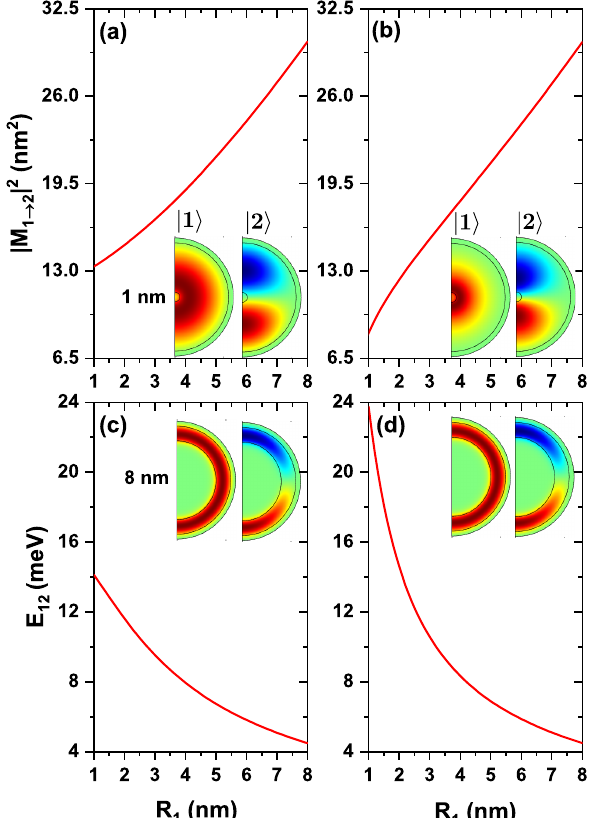
Figure 5. The variation of the | M 12 | 2 ( a , b ), and the transition energy ( c , d ), as functions of the internal radius R 1 , for transitions from the ground state ( | 1 (cid:105) ) to the first excited state ( | 2 (cid:105) ) with m = 0, for an electron confined in a ZnS/CdS/ZnS spherical QD. ( a , c ), present the results without, and ( b , d ) with the effects of a donor impurity located at the center of the dot system. Calculations are with R 2 = 11nm and R 3 = 12nm, without effects of external electric and magnetic fields. Variation of | M 12 | 2 and transition energy, E 12 , as functions of the internal radius for a confined electron in a ZnS/CdS/ZnS spherical QD with and without the effects of on- center donor impurity is shown in Figure 5. According to Figure 5a, by increasing the QD internal radius, the size of the shell -where the electron is confined- decreases, causing a linear increase of | M 12 | 2 . This behavior is shown in the inset, from which one may conclude that the spatial overlap between wave functions increases when moving from 1 nm to 8 nm in the internal radius. In Figure 5b, with the inclusion of donor impurity influence, a similar behavior is observed for | M 12 | 2 . From the inset in Figure 5b, it is seen that the ground state wave function is attracted to the impurity while the first excited wave function remains almost unchanged. Hence, the overlap between both states decreases concerning the case without impurity. For example, | M 12 | 2 has a value of 13.330 nm 2 for R 1 = 1 nm without impurity. With impurity effects, the value falls to 8.380 nm 2 , with a difference of 4.950 nm 2 , which becomes smaller as the radius increases, weakening the Coulombic interaction. Figure 5c,d show the corresponding variation of the transition energy from the ground state to the first excited state, with and without impurity, from which it is seen that as the R 1 increases, this energy decreases. As the internal